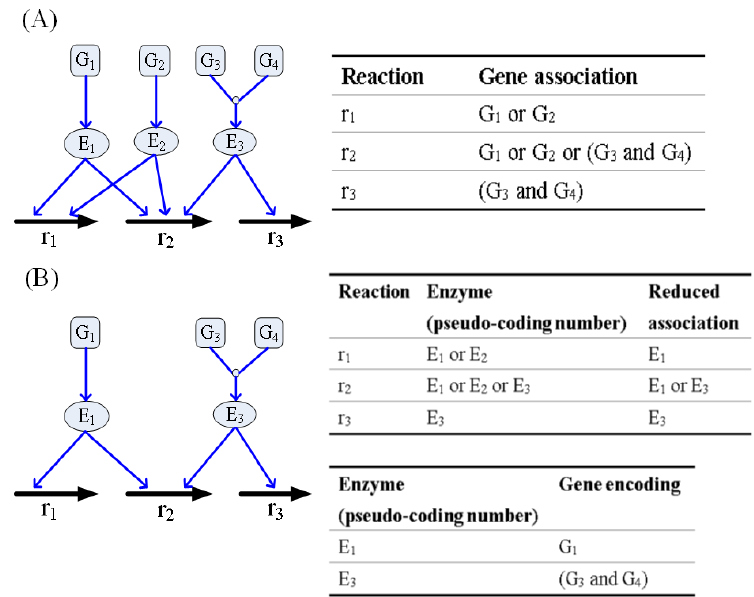
Figure 3. Example for building a gene-protein-reaction model using the enzyme pseudo-coding numbers. ( A ) Three reactions and their gene associations. ( B ) Reduced gene associations and encoded genes of the enzyme. E 2 is a redundant enzyme that is identical to E 1 and catalyzed the same reactions. r 2 is catalyzed by the isozymes (E 1 and E 3 ). E 1 is encoded by G 1 , and E 3 is encoded by a complex of G 3 and G 4